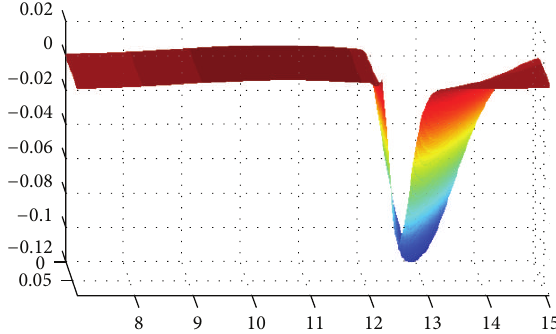
Figure1:Theleadingorder 𝑃 0 withrespecttothepriceofunderlying asset 𝑋 𝑡 and the barrier time 𝜏 𝑡 . Figure 2: The correction term ̃𝑃